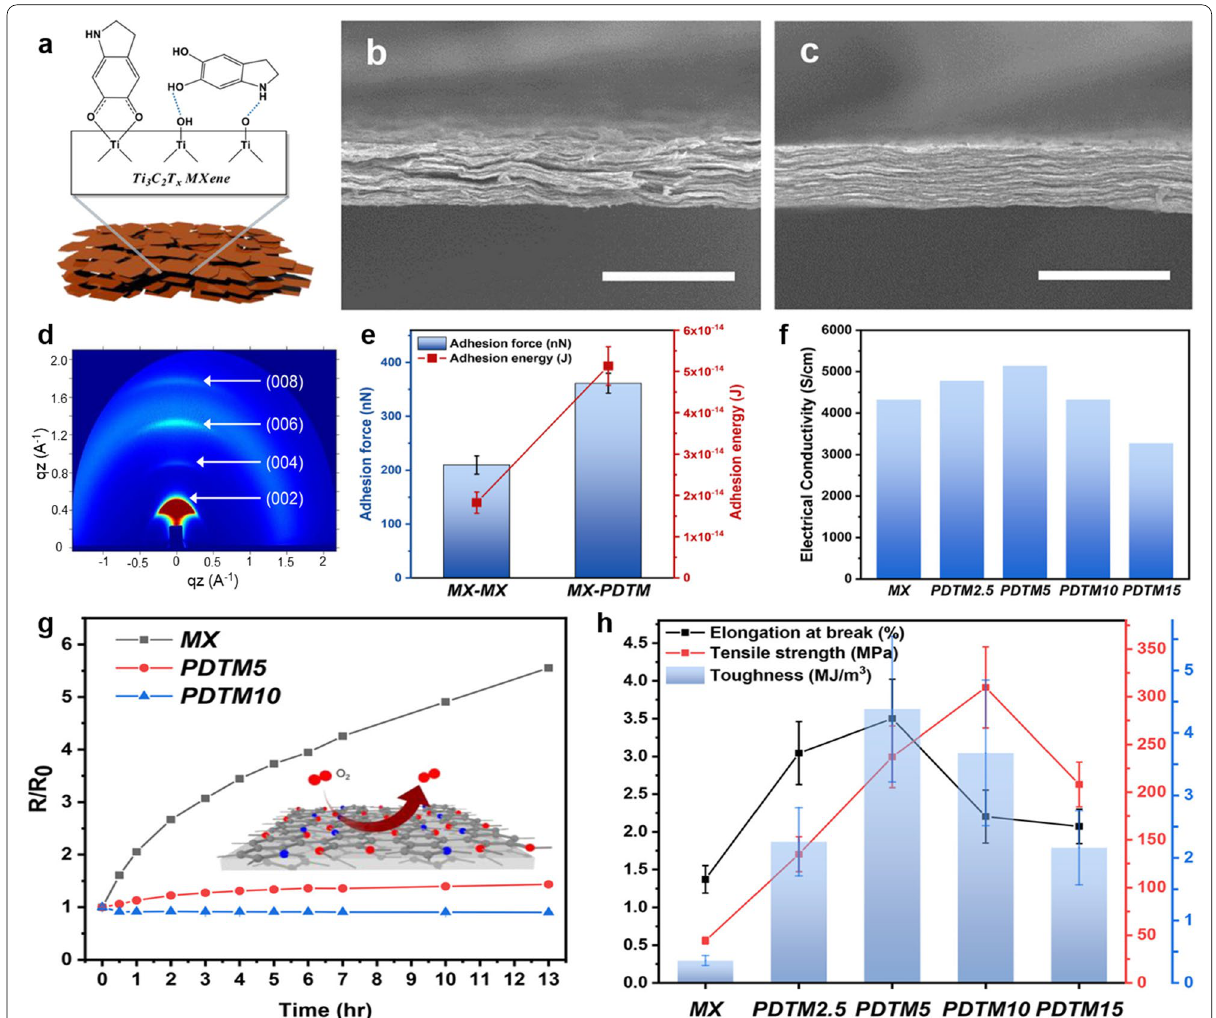
Fig. 13 a Schematic illustration of fabrication procedure polydopamine-treated MXene composite (PDTM). SEM cross-sectional images of b MXene and c PDTM5 (scale bar: 20 μm). d GIWAXS patterns of PDTM5. e Adhesion force and energy calculated from the force-distance curve. f Electrical conductivity of each sample. g Electrical resistance change of pure MXene and polydopamine-treated MXene composites upon heating (170 °C) in air. h Calculated tensile strength, elongation, and toughness of neat MXene and its PDTM composites. a – h Reproduced with permissions from ref. [65]. Copyright (2020), American Chemical